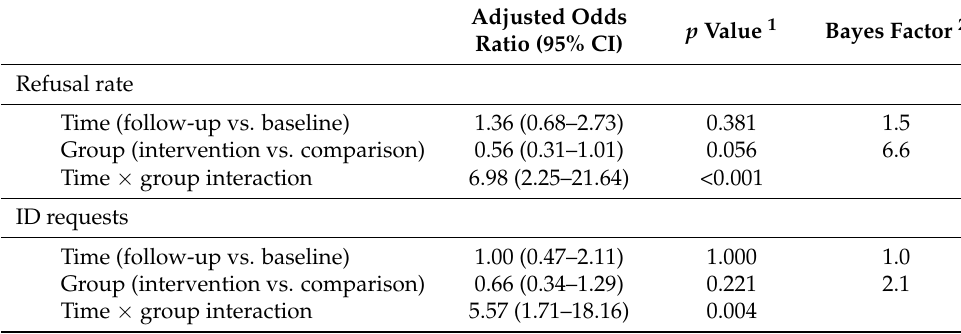
Table 3. Binary logistic regression to adjust for baseline